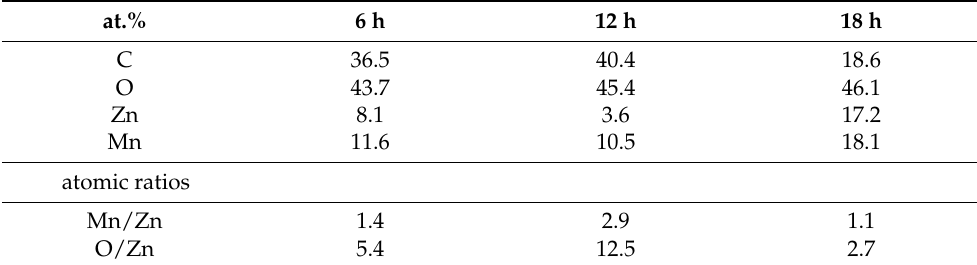
Table 3. Atomic concentrations (at.%) and atomic ratios.